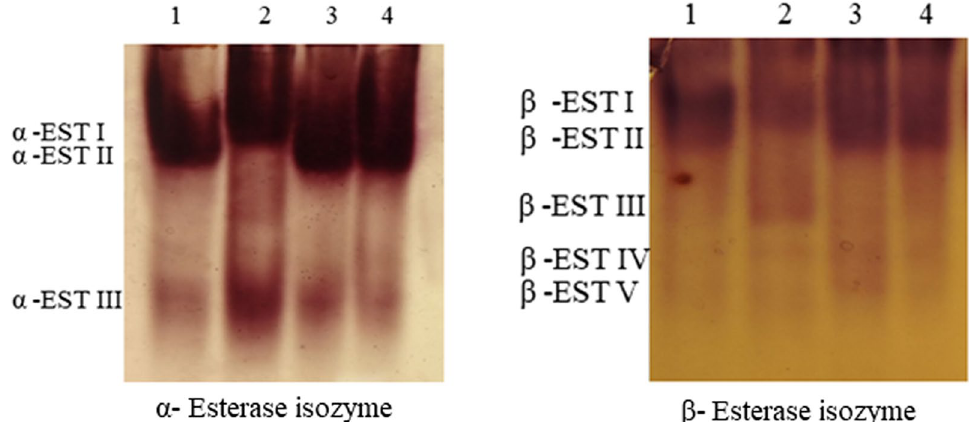
Fig. 5 Expression of α‑EST and β‑EST zymogrames in roots of Allium cepa treated with (1) tap water as control, (2) 25%, (3) 50% and (4) 100% of mixed wastewater at 12th day after